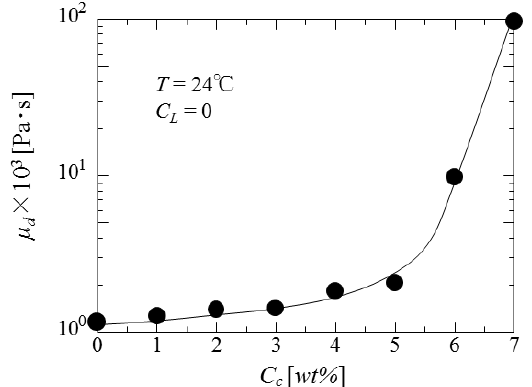
Figure 8. Dependence of viscosity of dispersed phase on curdlan concentration.